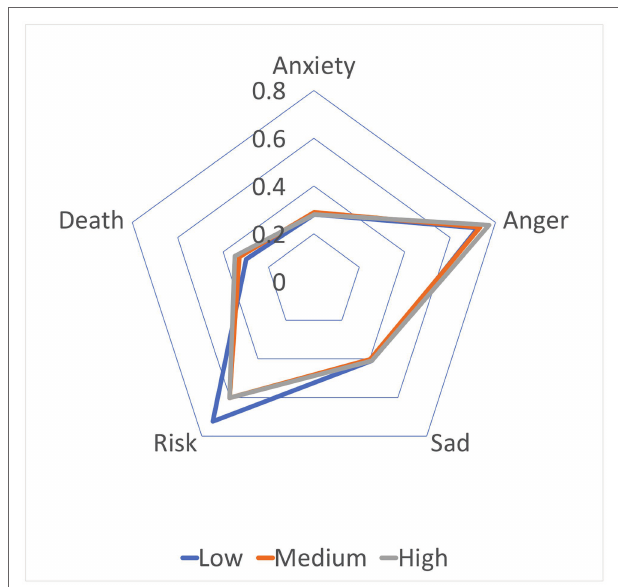
FIGURE 3 | Exploration of categories of negative emotions. Note. We divided the case numbers by percentiles into three groups, low-risk group (fewer than 564 cases), medium-risk group (between 564 cases and 2,085 cases), and high-risk group (higher than 2,085